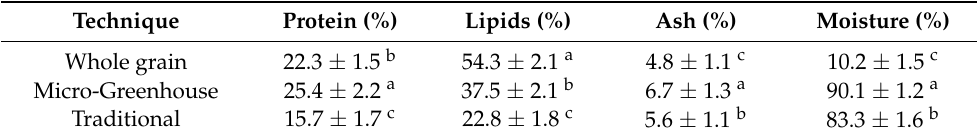
Table 6. Nutritional sesame sprout